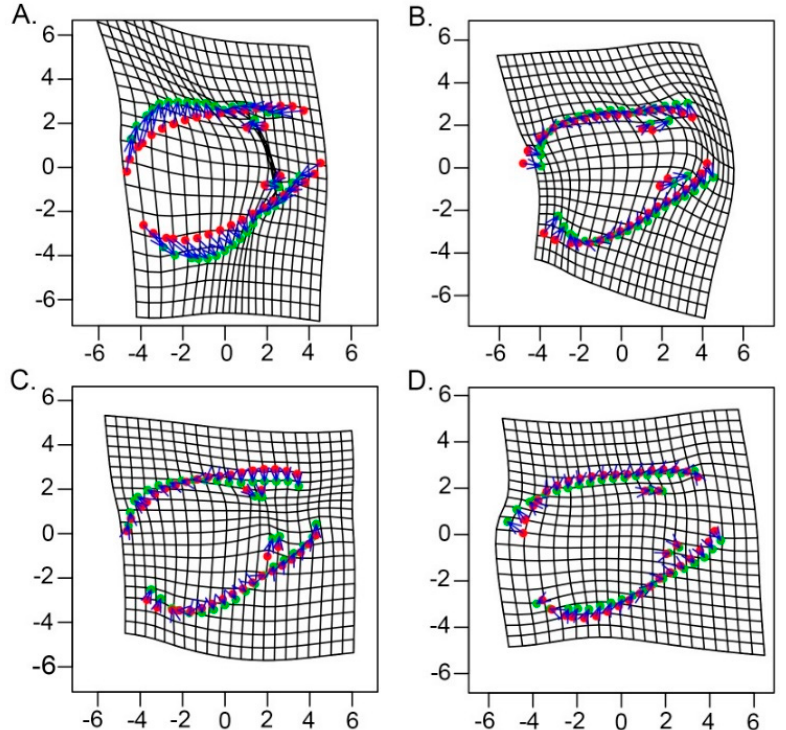
Figure 3. Thin plate spline deformation grids of Eurycea waterlooensis showing transformations from low to high principal component (PC) factor scores modeled at two standard deviations below and above the mean value for ( A ) PC 1; ( B ) PC 2; ( C ) PC 3; ( D ) PC 4.